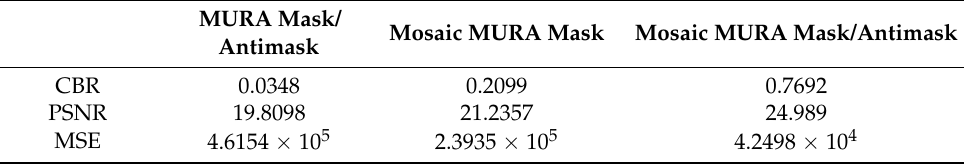
Table 1. Performance comparison among MURA mask/antimask, mosaic MURA mask and mosaic MURA